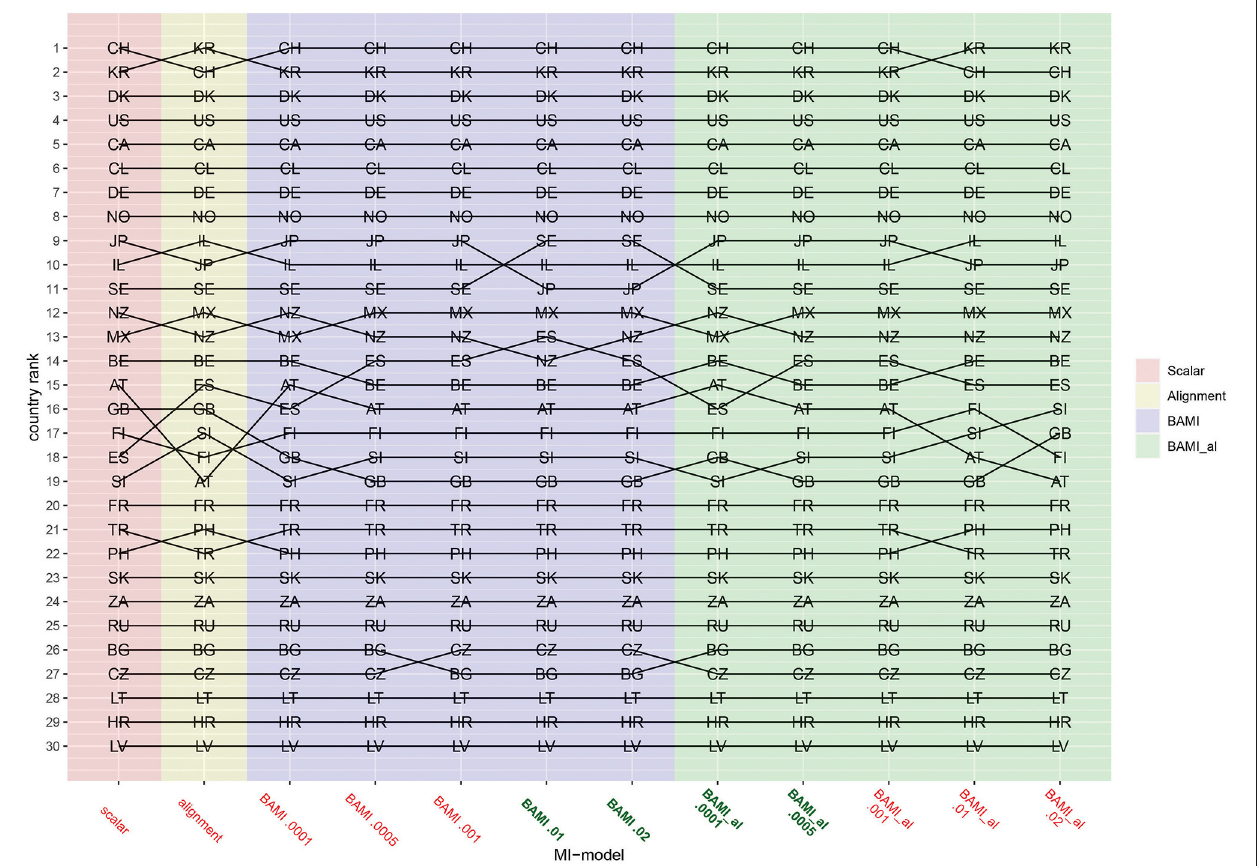
FIGURE 4 | Rankings per model. AT, Austria; BE, Belgium; BG, Bulgaria; CA, Canada; CL, Chile; HR, Croatia; CZ, Czech Republic; DK, Denmark; FI, Finland; FR, France; DE, Germany; GB, Great Britain; IL, Israel; JP, Japan; LV, Latvia; LT, Lithuania; MX, Mexico; NZ, New Zealand; NO, Norway; PH, Philippines; RU, Russia; SK, Slovakia; SI, Slovenia; ZA, South Africa; KR, South Korea; ES, Spain; SE, Sweden; CH, Switzerland; TR, Turkey; US, United States. The x-axis shows the different models—scalar, ML alignment, and BAMI with and without alignment—with their specific variances. Models that appear to ba a good fit to the data are indicated in bold green, models with bad fit in